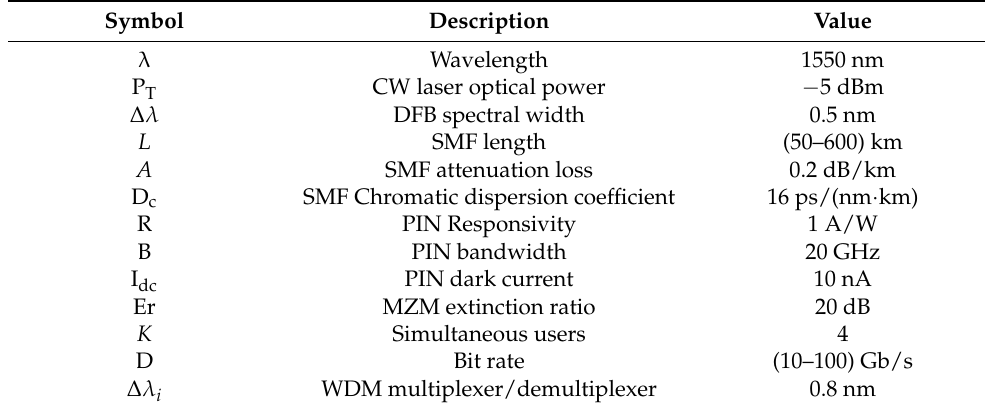
Table 4. Numerical simulations